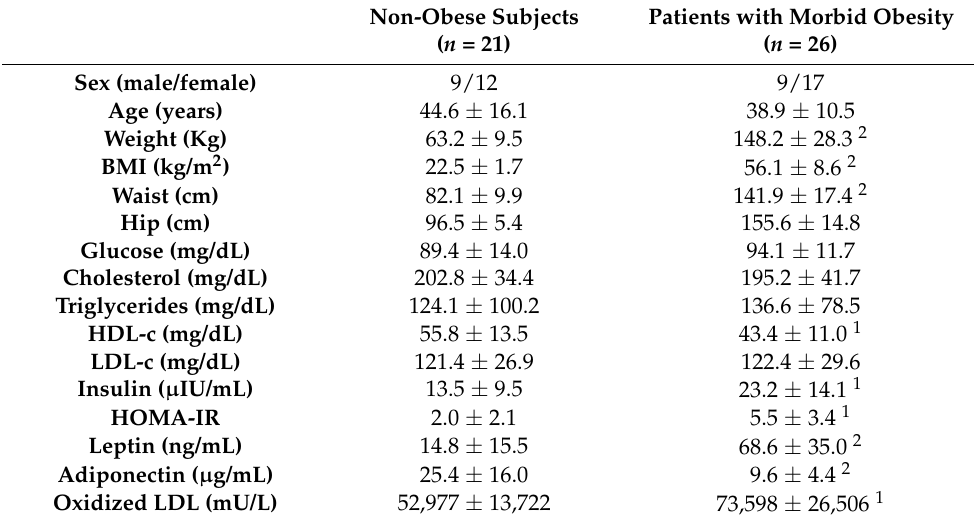
Table 1. Anthropometric and biochemical variables in the non-obese and morbidly obese subjects. Non-Obese Subjects Patients with Morbid Obesity ( n = 21) ( n = 26) Sex (male/female) 9/12